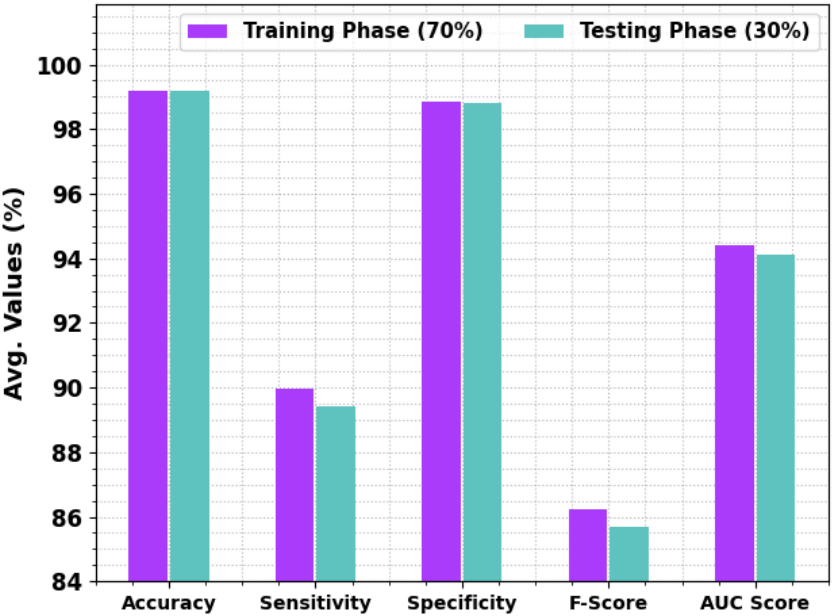
Figure 5. The average outcome of the BCOA-MLID approach on TRP/TSP of 70:30.